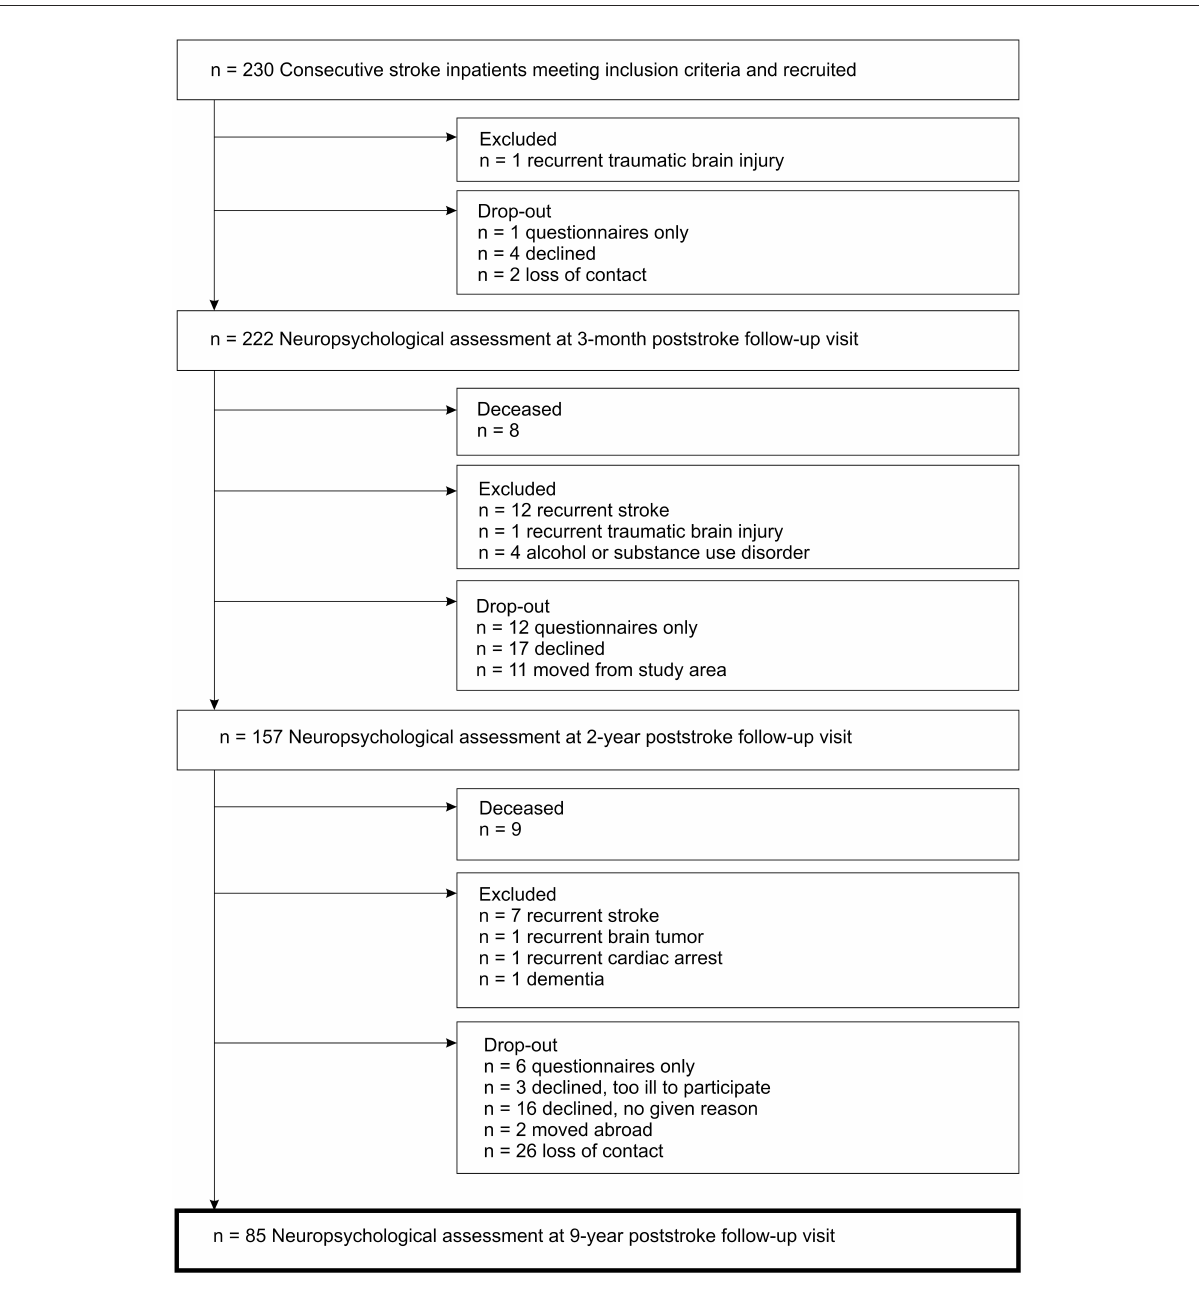
FIGURE1 Flow diagram of the inclusion process for the study cohort with first-ever ischemic